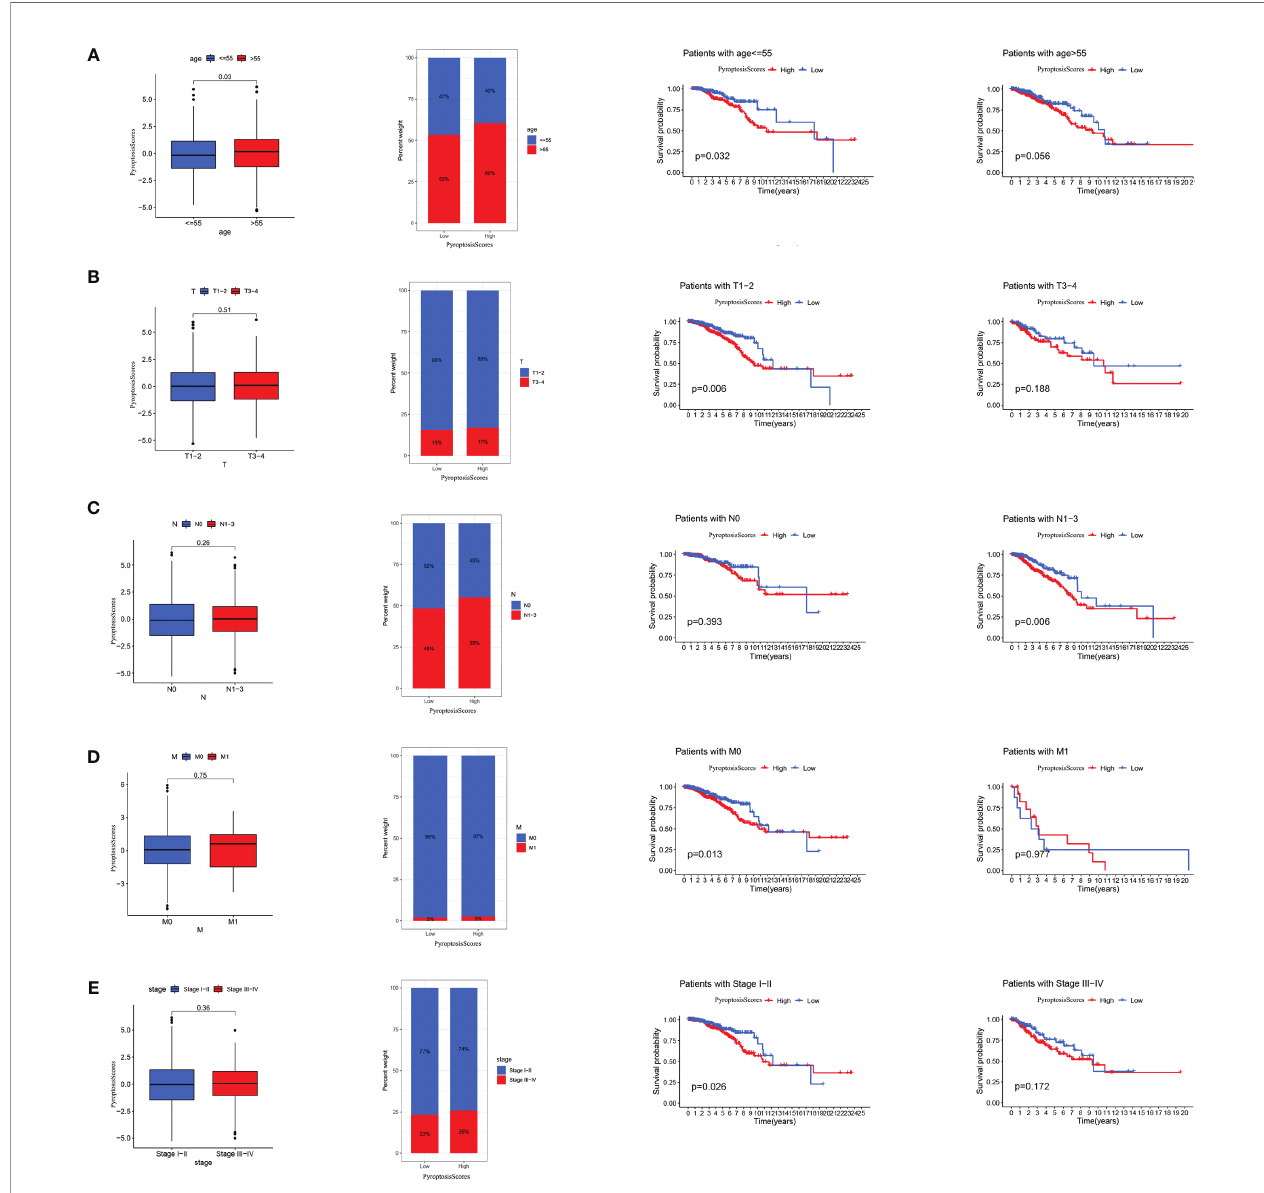
FIGURE 6 | The relationship between PyroptosisScore and clinic in the TCGA-BRCA cohort. The relationship between age (A) , T (B) , M (C) , N (D) , stage (E) and PyroptosisScore. The TNM system of cancer staging re fl ects the extent of tumor growth, where primary tumor (T), nodal status for metastasis (N), and metastasis at the distant organs